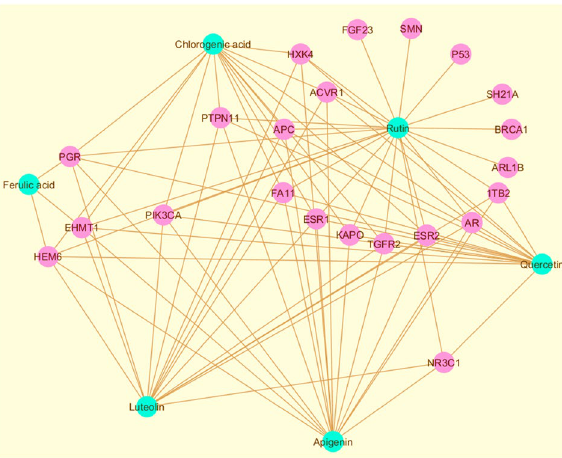
Figure 5. Compound-Target (C-T) network of Chrysanthemum bioactive compounds. Nodes represent bioactive compounds and